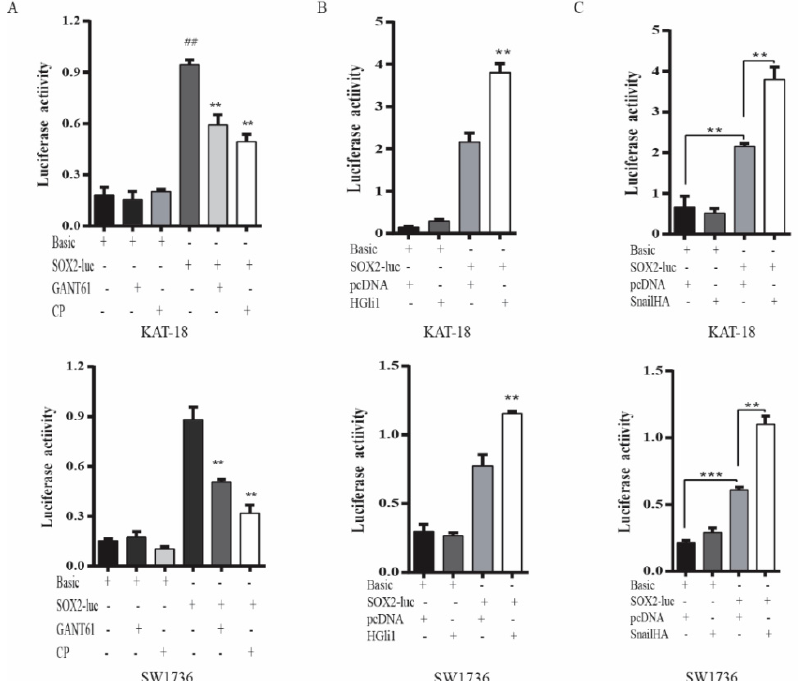
Figure 4. The Shh pathway regulated SOX2 promoter activity. ( A ) KAT ‐ 18 and SW1736 cells were transiently transfected with the pGL3/Basic or the SOX2 promoter ‐ driven luciferase reporter (pGL3/SOX2 ‐ Luc) and incubated for 48 h in the absence or presence of GANT61 (10 μ M) or cyclopamine (10 μ M) for 48 h. ( B ) KAT ‐ 18 and SW1736 cells were transient transfected with the pGL3/Basic or the SOX2 promoter ‐ driven luciferase reporter (pGL3/SOX2 ‐ Luc) plus the empty pcDNA3.1 vector or the expression vector encoding human Gli1 ( B ) or Snail ( C ) and incubated for 48 h. The cell lysates were prepared and analyzed for luciferase activity. Data represent the results of one of two experiments with similar results. * p < 0.05; ** p < 0.01, *** p < 0.001, compared to the untreated control; ## p <0.01, compared to the pGL3/Basic control.